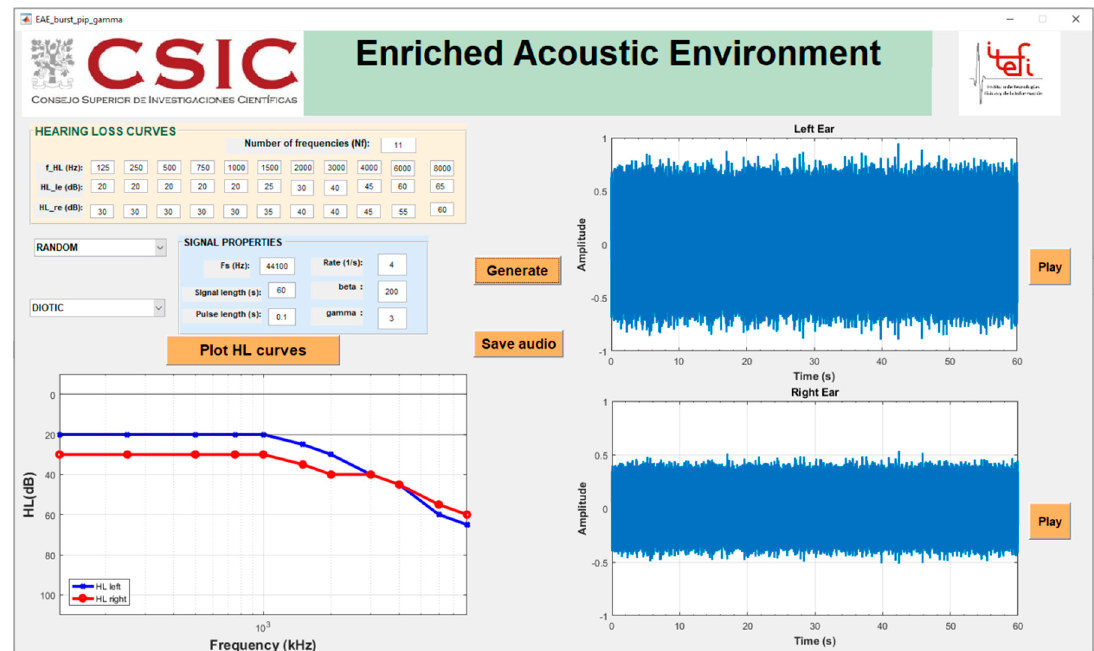
Figure 6. Custom-designed GUI for tinnitus sound therapy.